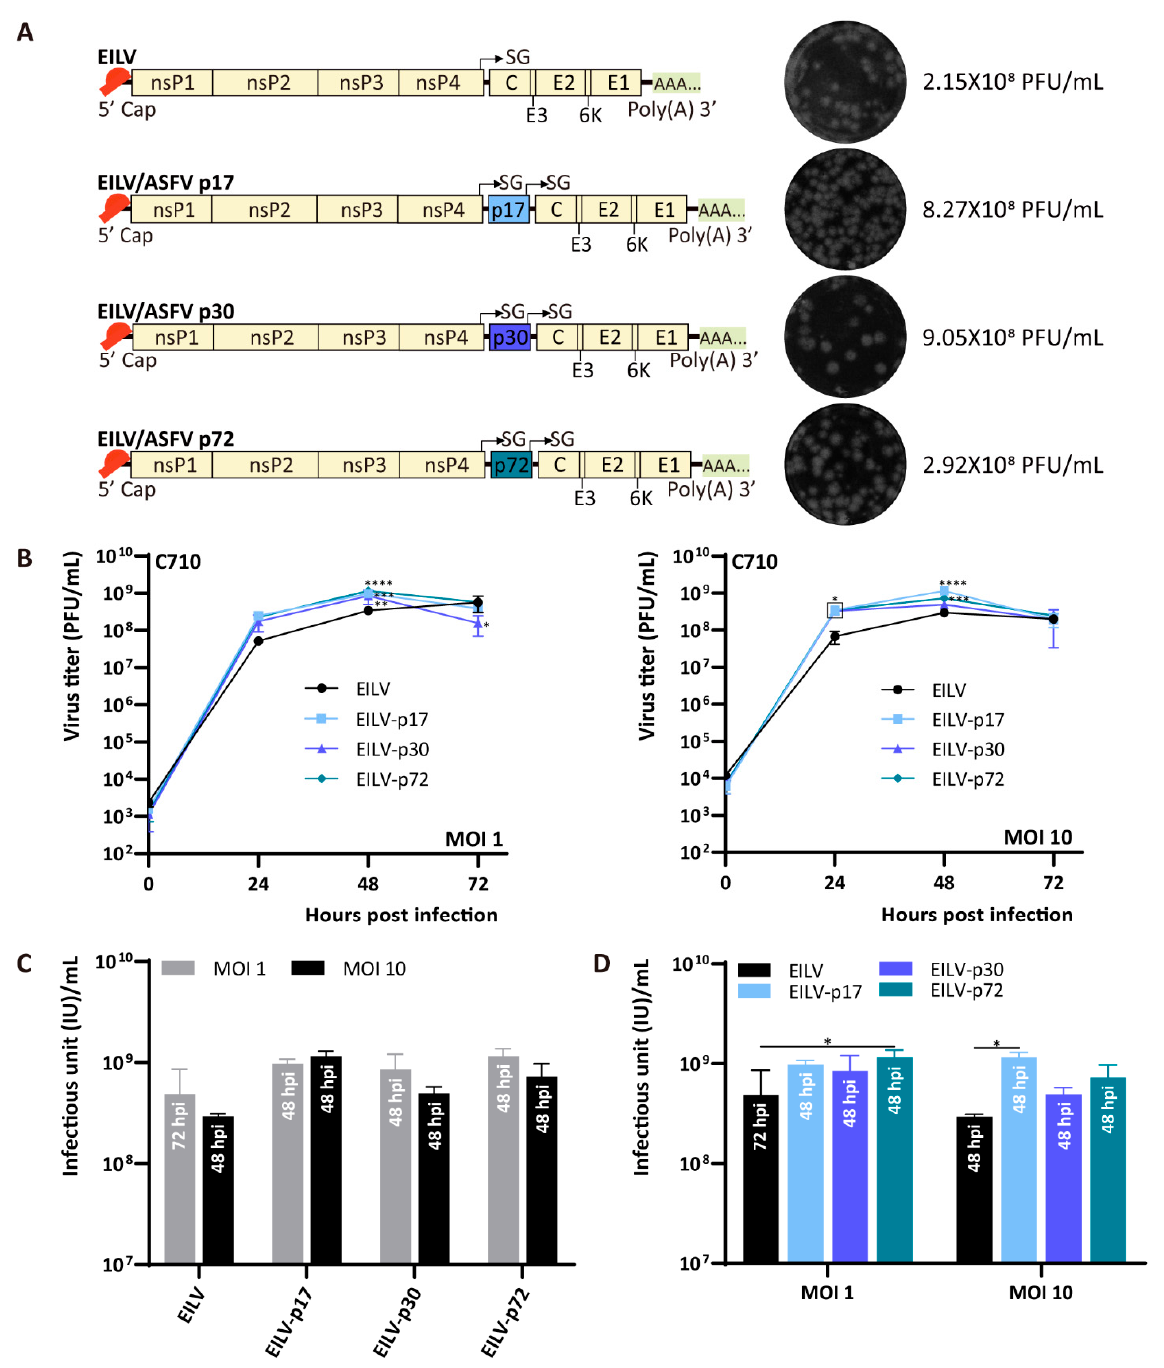
Figure 5. Genome organization and replication kinetics of EILV-based double SG variants expressing African swine fever virus (ASFV) antigens. ( A ) Genome organization of EILV/p17, EILV/p30, and EILV/p72 recombinants. Viruses were rescued on C7/10 cells and harvested at 3 dpe. Rescue titers and plaque phenotypes are displayed. ( B ) Replication kinetics in C7/10 cells. Cells were infected at an MOI of 1 or 10. Media were collected at the indicated time points post-infection, and titers were determined by plaque assay. ( C ) The optimal titers obtained from each virus with different MOIs. ( D ) Comparison of the optimal titers produced by EILV and recombinants. The annotation embedded in each bar in ( C ) and ( D ) indicates the time point reaching the highest titer. Each sample was titrated twice ( n = 2). Average titers ± standard deviations SD (error bars) are shown. *, p < 0.05; **, p < 0.01; ***, p < 0.001; ****, p < 0.0001.